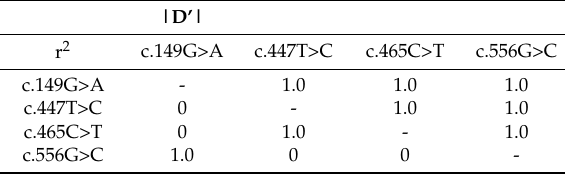
Table 2. Linkage Disequilibrium (LD) among four polymorphisms of PRND gene in dogs.